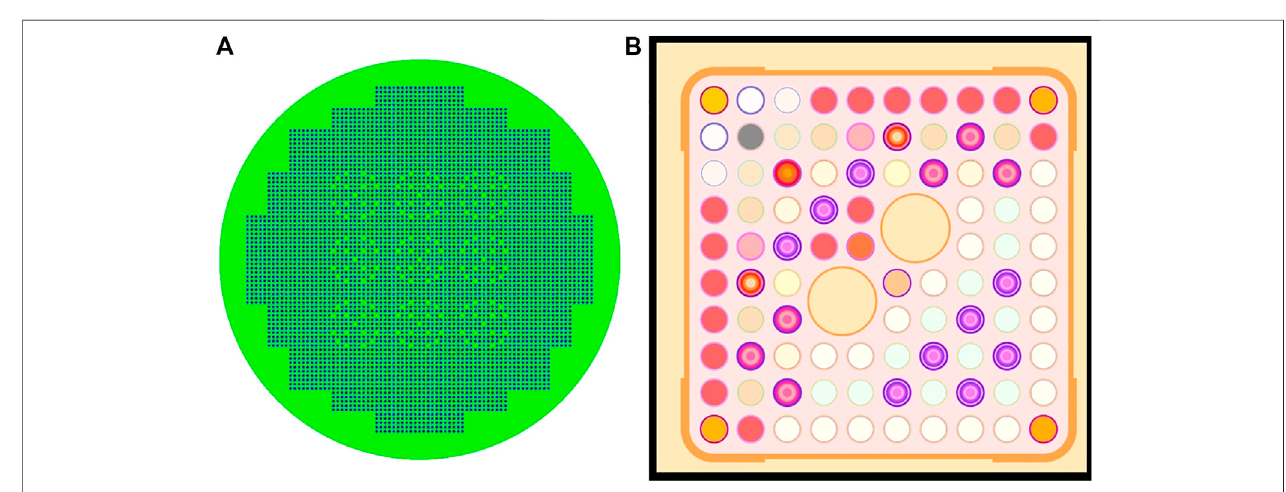
FIGURE 7 | Low-relevant case layouts of the representative models. (A) Experiment model: LCT-008-001 (B) Application model: ATF assembly.